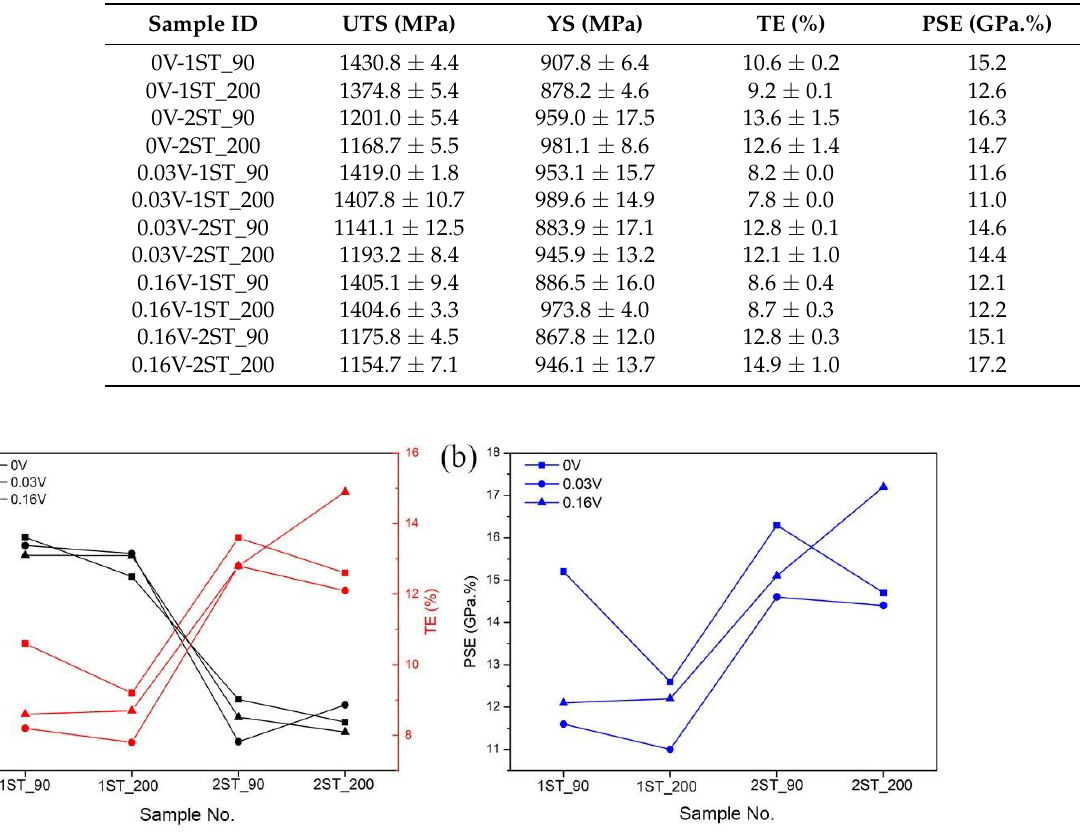
Figure 3. Mechanical properties of the three experimental steels treated by Q&P process: ( a ) UTS and TE, ( b ) PSE.